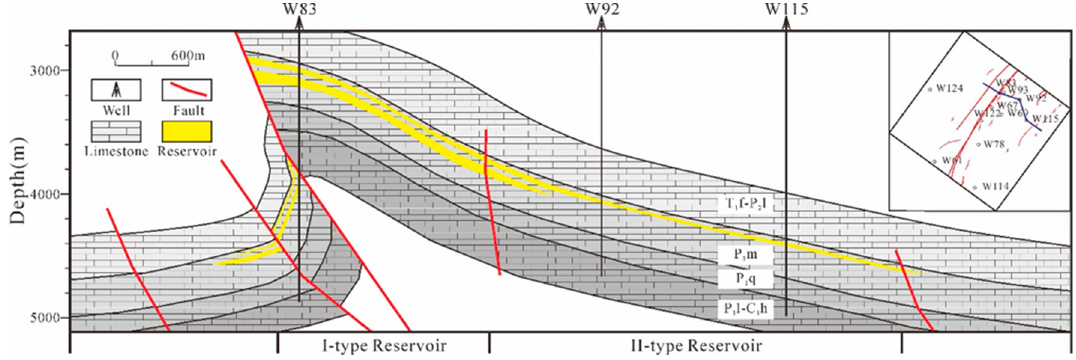
Figure 17. Geological profile of hydrothermal karst dolomite paleokarst reservoir in Wolonghe gas field. Note: The seismic profile is shown in Figure 13a, and the RIL reservoir indicator factor profile is shown in Figure 14.